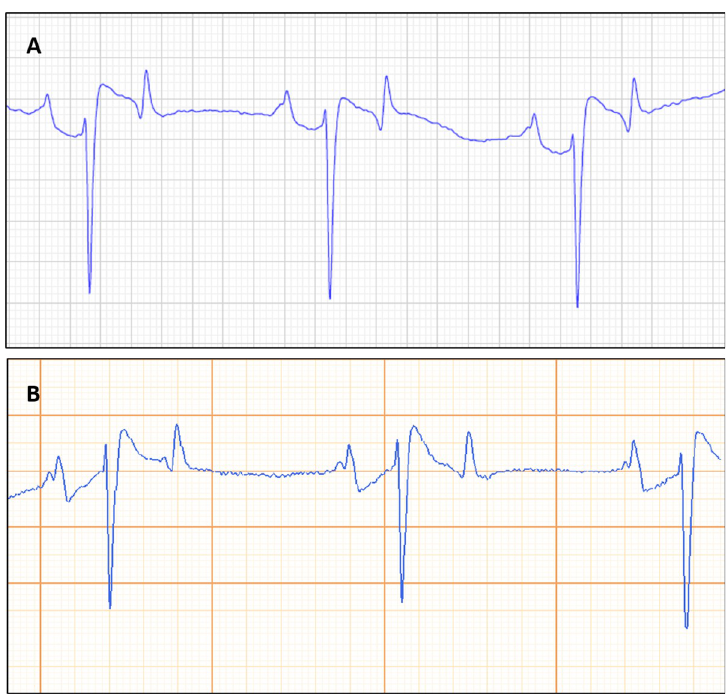
Fig 4. Side-by-side example of a tracing obtained simultaneously with reference ECG (rECG; A) and smartphone ECG (spECG; B) showing the same polarity of the cardiac deflections. Paper speed = 25 m/s; 10 mm/mV.